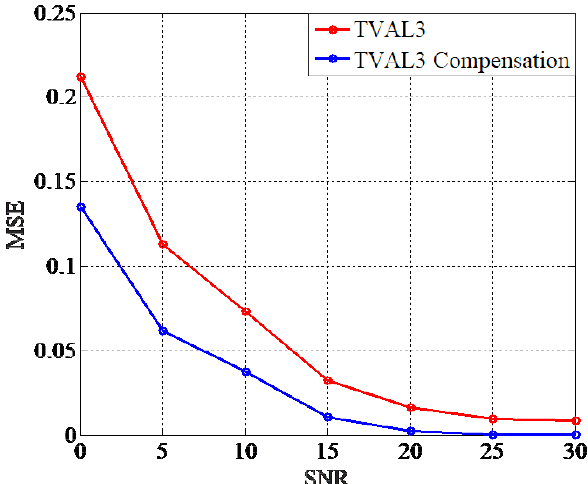
Figure 9. Influence of different SNRs with TVAL3